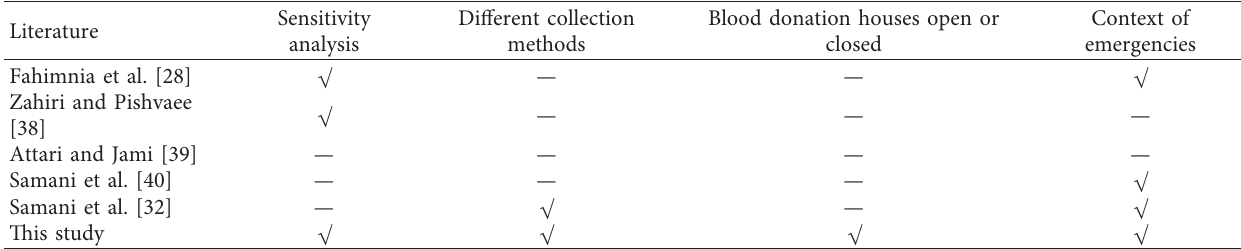
Table 3: Factors considered in some key